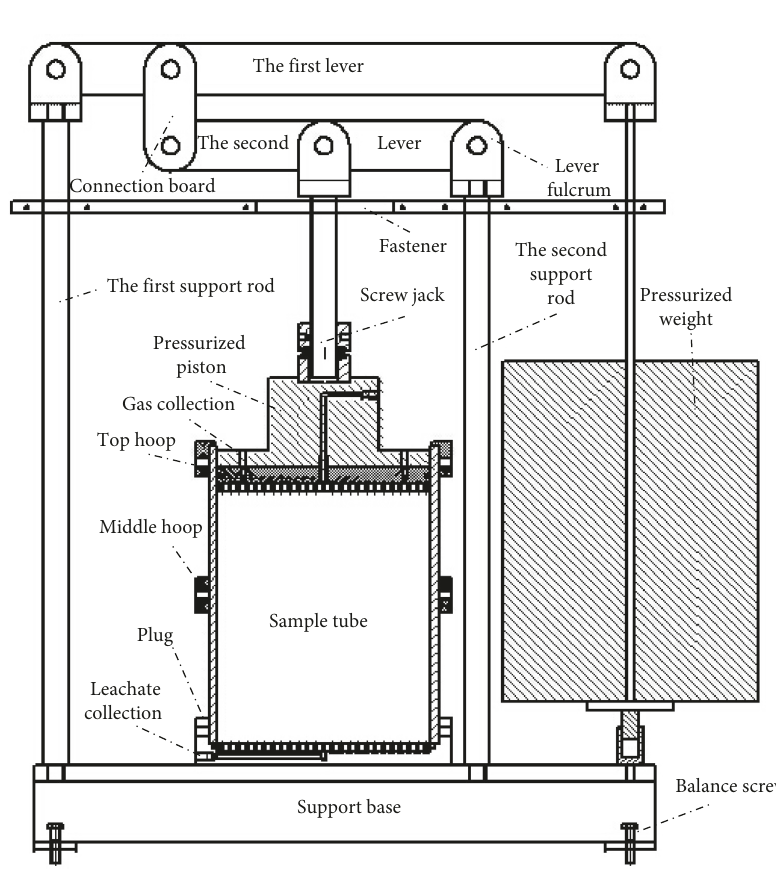
Figure 1: Compression instrument of